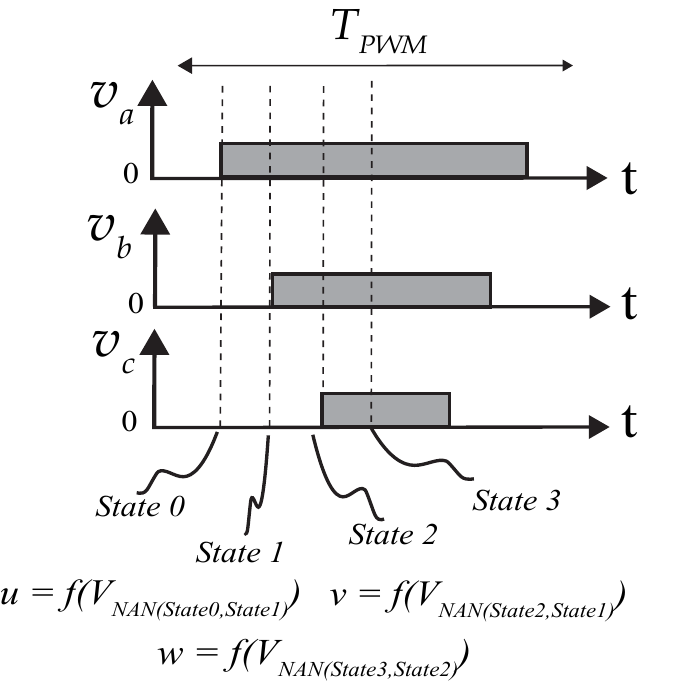
Figure 2. Original DFC measurement sequence: Inverter’s states for DFC flux linkage